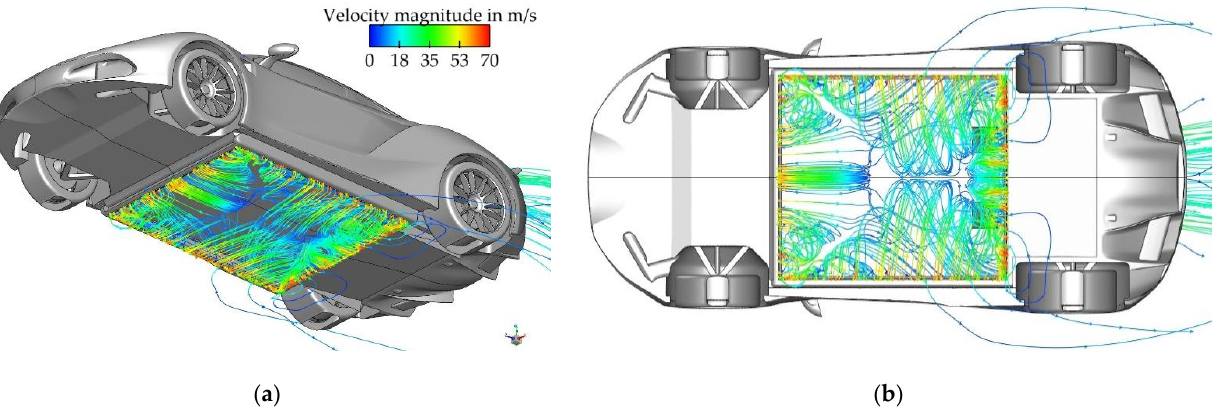
Figure 29. Pathlines released from the fan surfaces for inlet velocity of 20 m/s. ( a ) Angled view from bottom; ( b ) Bottom view.